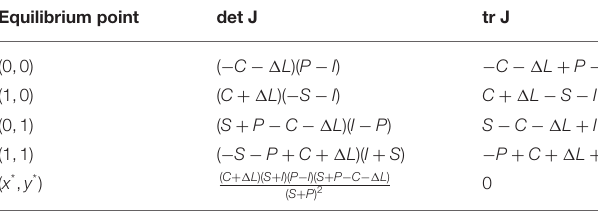
TABLE 2 | Analysis results of local stability. Equilibrium